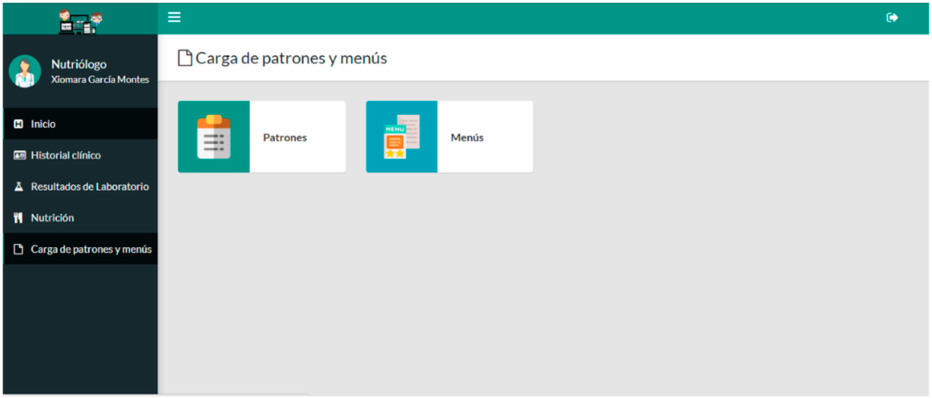
Figure 32. Nutritionist application interface: Module loading patterns and